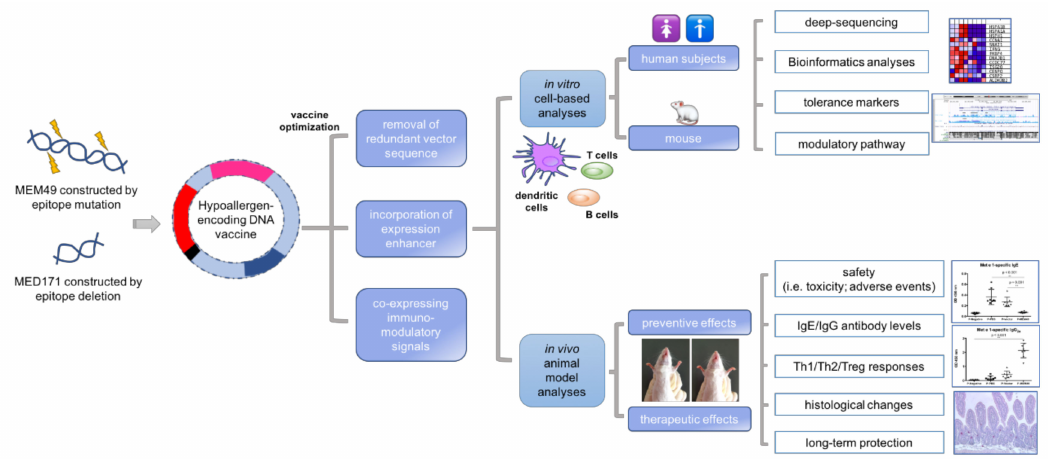
Figure3. Experimentaldesignofthehypoallergen-encodingDNAvaccinestudy. Twohypoallergens, MEM49 and MED171, of shrimp tropomyosin were constructed by epitope mutation and deletion, respectively. DNA vaccines were then constructed by cloning and expressing the hypoallergens in mammalian expression plasmids. Our data demonstrated that pMEM49 and pMED171 were e ff ective in down-modulating shrimp tropomyosin-induced allergy in BALB / c mice, such as suppressing the Met e 1 - specific IgE and inflammatory responses in the gut while increasing specific IgG 2a with inhibitory functions. Optimization of the vaccines would follow in constructing next-generation DNA vaccines with enhanced in vivo expression of the hypoallergen and immunogenicity of the vaccines. In vitro cell-based analyses involving the major immune players (e.g., dendritic cells, T and B cells) in human and mouse to dissect the modulatory mechanism of the hypoallergen-encoding DNA vaccines, as well as in vivo analyses in murine model for the safety and therapeutic e ffi cacies of the vaccines are essential in addressing the applicability of the vaccines for the clinical treatment of shellfish